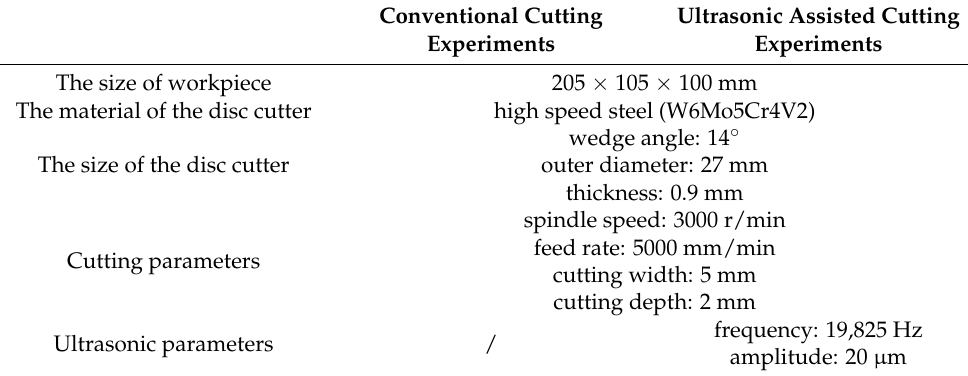
Table 2. The experimental parameters.